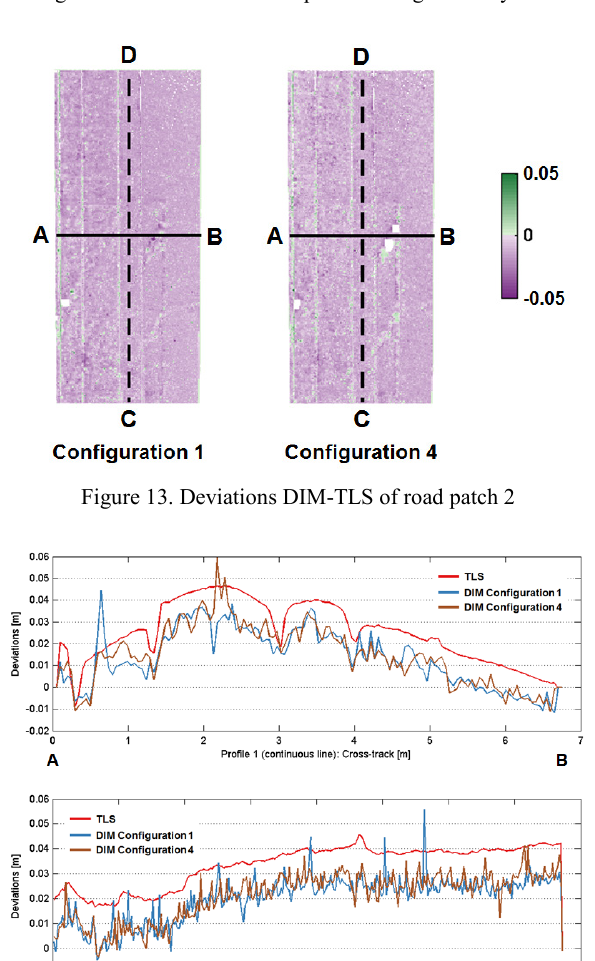
Figure 12. Extraction of road patch 2 using Leica Cyclone